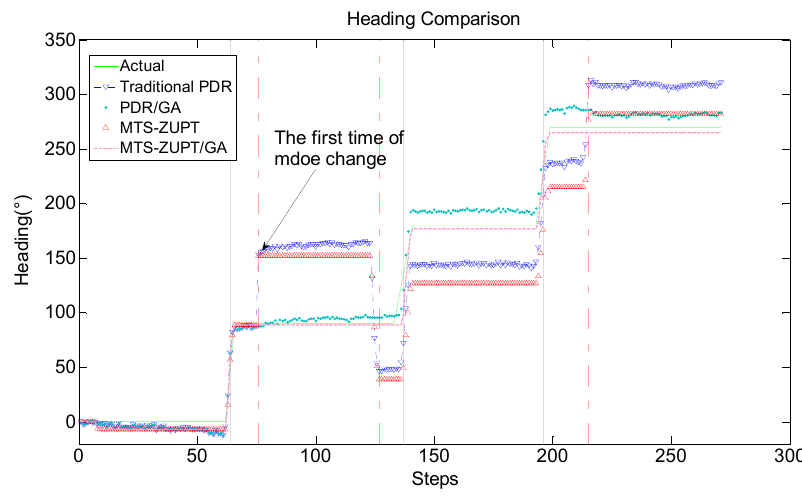
Figure 12. Heading Comparison.